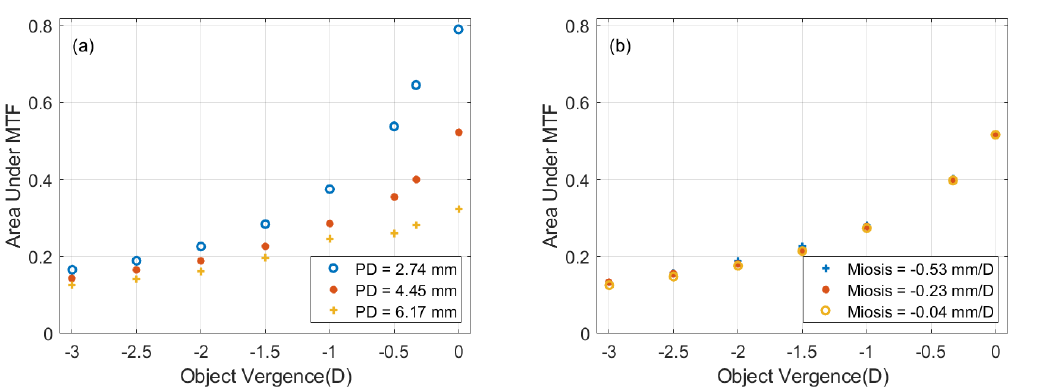
Figure 4. Area under MTF as a function of object vergence in diopters, from near ( OV = − 3 D) to far ( OV = 0 D) object distances: ( a ) Case 1 models with constant pupil miosis and varying distance pupil diameter (PD) values; and ( b ) Case 2 models with constant distance pupil and varying pupil